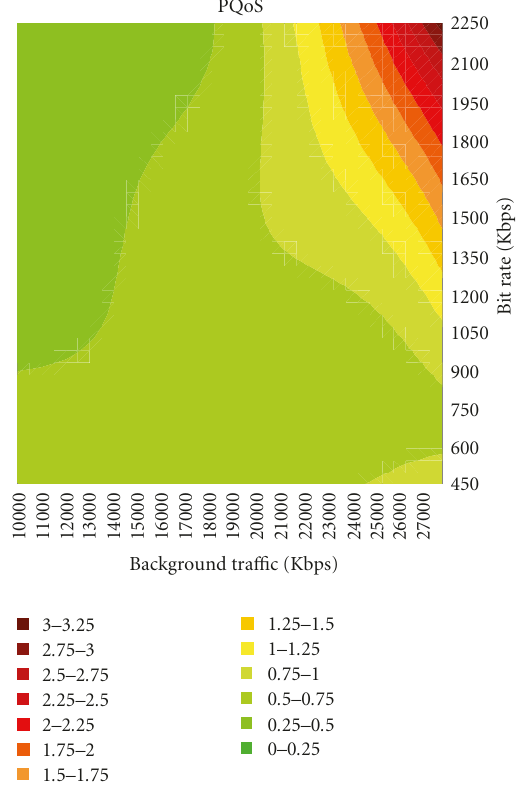
Figure 7: PQoS map obtained from the analytical model, back- ground tra ffi c versus video bit